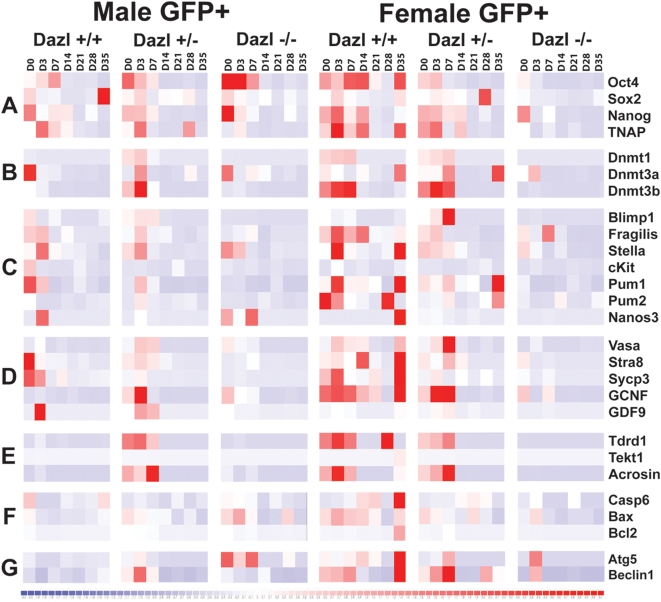

Dazl Mutant mESCs Display Aberrant Gene Expression of Pluripotency and Germ Cell Markers During Differentiation.Gene expression profiles are shown from GFP-positive cells, isolated by FACs, from day 0, 3, 7, 14, 21, 28, and 35 of differentiation. Expression is represented by heat map generated on DChip displaying a continuum with high expression depicted by red to low expression, in blue. The numeric values are from the formula 2∧(−ΔCt), with GAPDH as the housekeeping gene, on a log scale. Genes are classified based by functional group as follows. Group A consisted of the pluripotency related genes Oct4, Sox2, Nanog, and TNAP (Tissue-non-specific alkaline phosphatase). Group B contains epigenetic regulators from the DNA methyltransferase family, Dnmt1, Dnmt3a, and Dnmt3b. Group C consists of the primordial germ cell specific markers Blimp1, Fragilis, Stella, cKit, Pumilio1 (Pum1), Pumilio2 (Pum2), and Nanos3; Group D contains the gonocyte markers Vasa, Stra8, Sycp3 (Synaptonemal Complex Component 3), GCNF, and GDF9. Group E contains the late germ cell markers Tdrd1 (Tudor domain containing 1), Tekt1 (tektin1), and Acrosin; Group F contains pro-apoptotic markers Casp6 (Caspase6) and Bax (BCL2-associated X), as well as the anti-apoptotic marker Bcl-2; Group G contains markers of autophagy including Atg5 (autophagy related 5) and Beclin1.